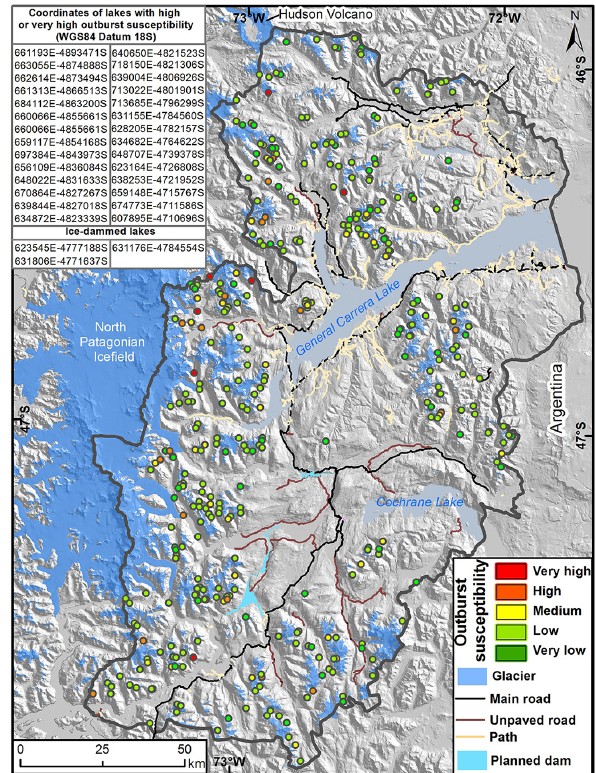
Figure 13. Classification of lake outburst susceptibility in the Baker Basin. Note that most of the lakes with high or very high outburst susceptibility are located on the west side of the